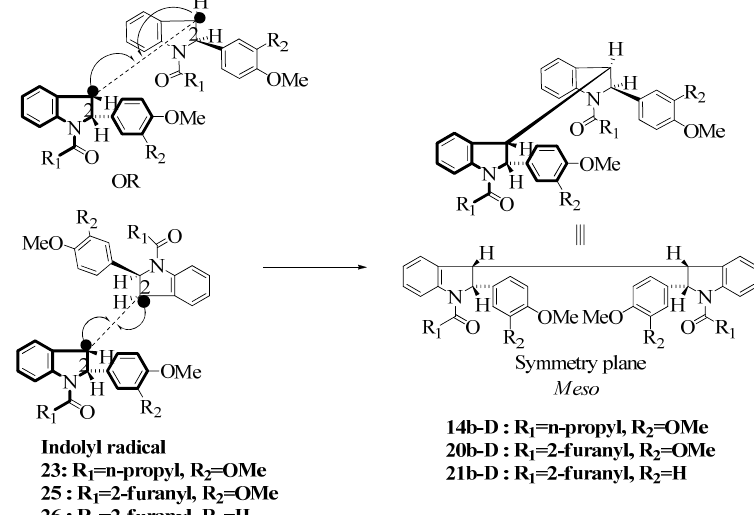
Scheme 7. Dimerization pathways leading the stereoisomers 14b-D , 20b-D and